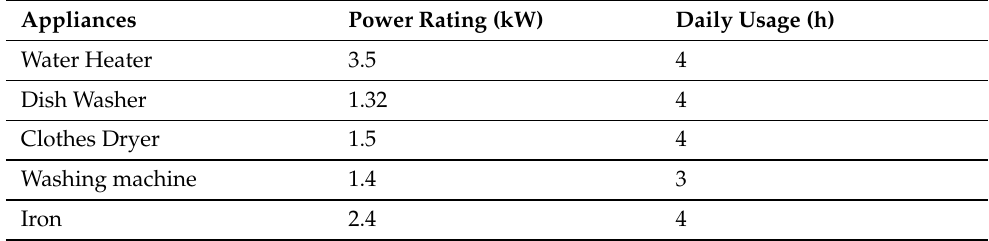
Table 2. Appliances specification and